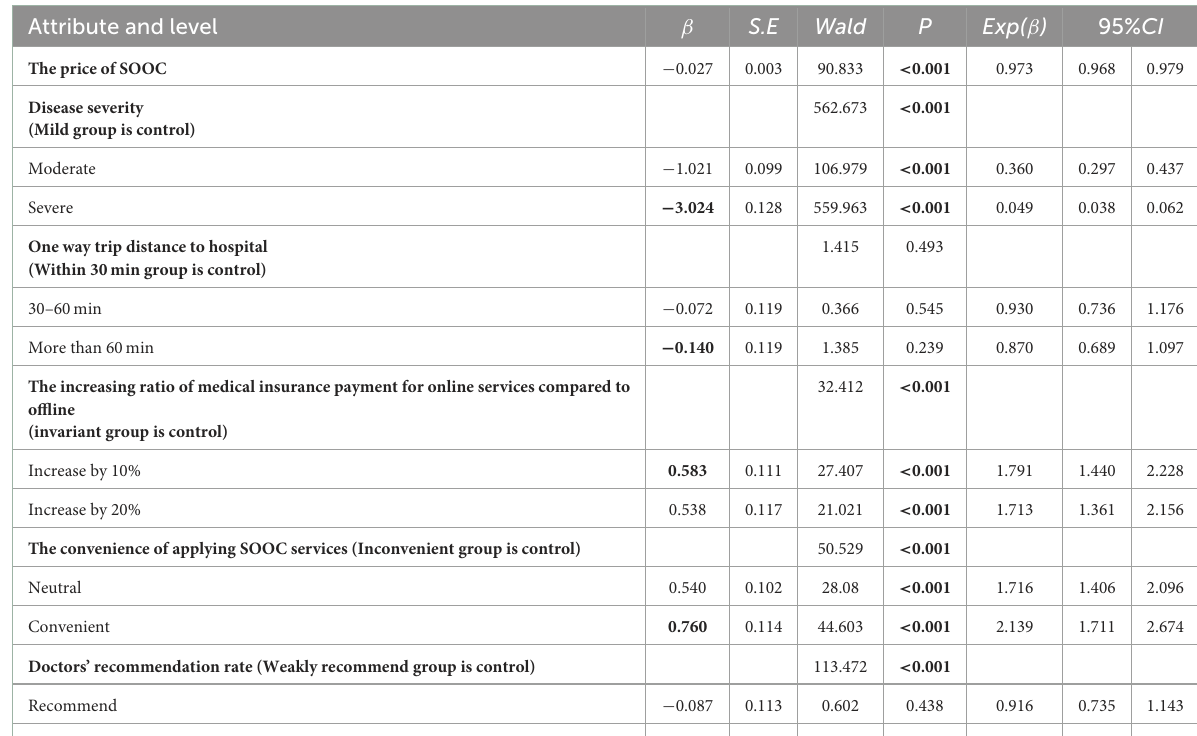
TABLE 4 Patients’ preference for